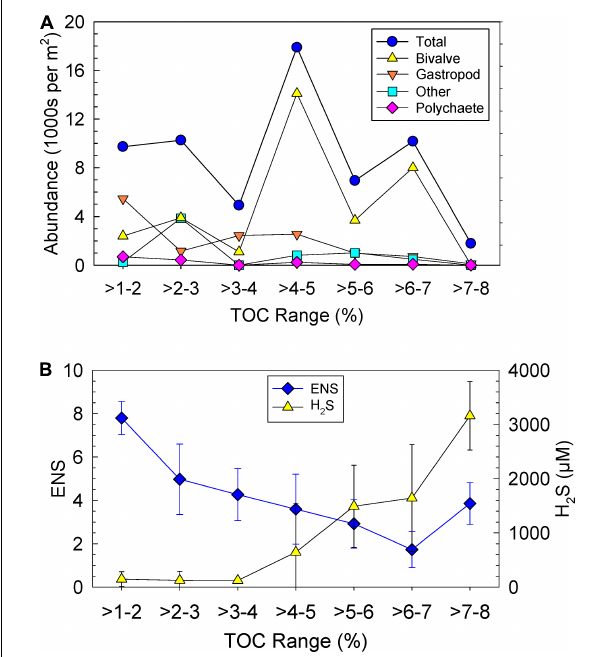
FIGURE 5 | Ranges in sediment total organic carbon (TOC) vs. (A) average abundances of four classes of taxa per m 2 and (B) average effective number of species (ENS) and porewater hydrogen sulfide (H 2 S) with standard